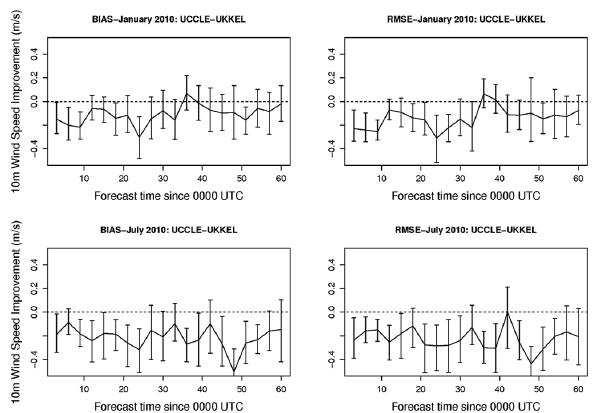
Fig. 8. The improvement in bias (left) and rmse (right) of the 10m wind speed obtained when using SURFEX for Jan- uary (top) and July (bottom). The 95% confidence intervals for | bias |−| bias | and rmse − rmse OPER + SFX OPER OPER + SFX OPER were calculated with the bootstrap method.